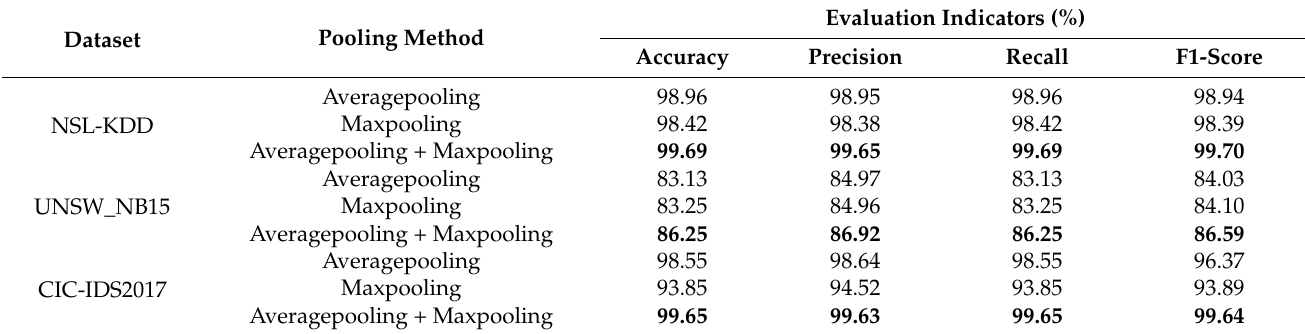
Table 11. Comparison of different pooling